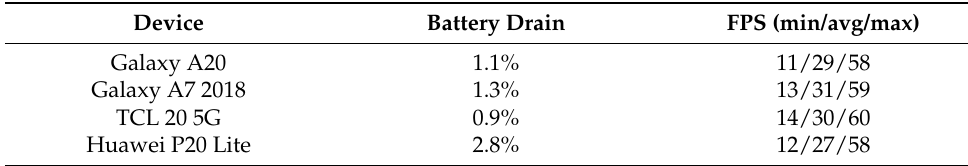
Table 2. Average results of 10 tests of 10 object question